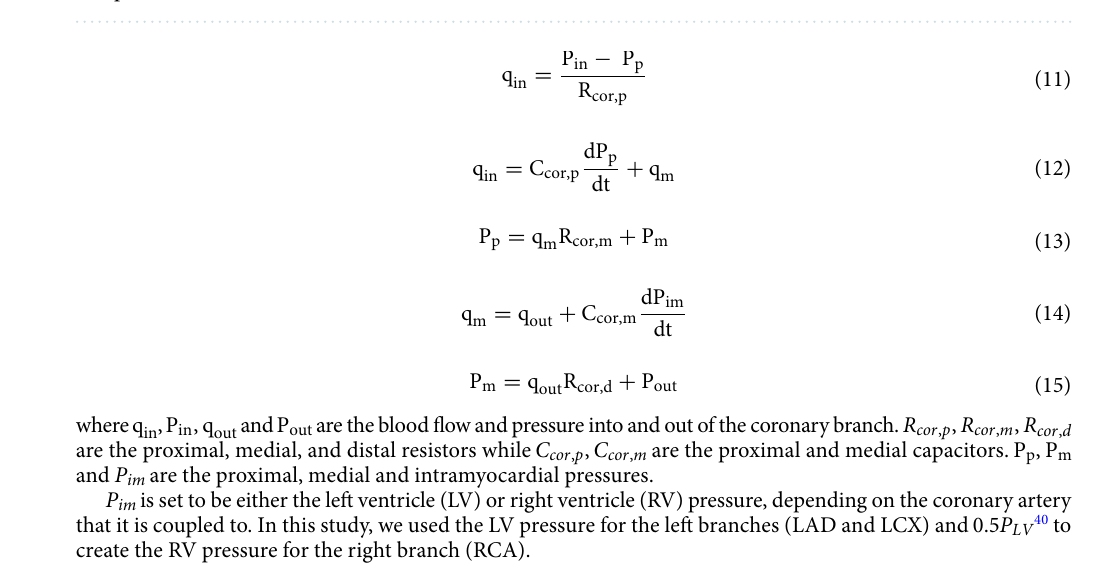
Figure 11. Time averaged wall shear stress of the aortic root during diastole for patients #1 and #2 in both pre and post intervention